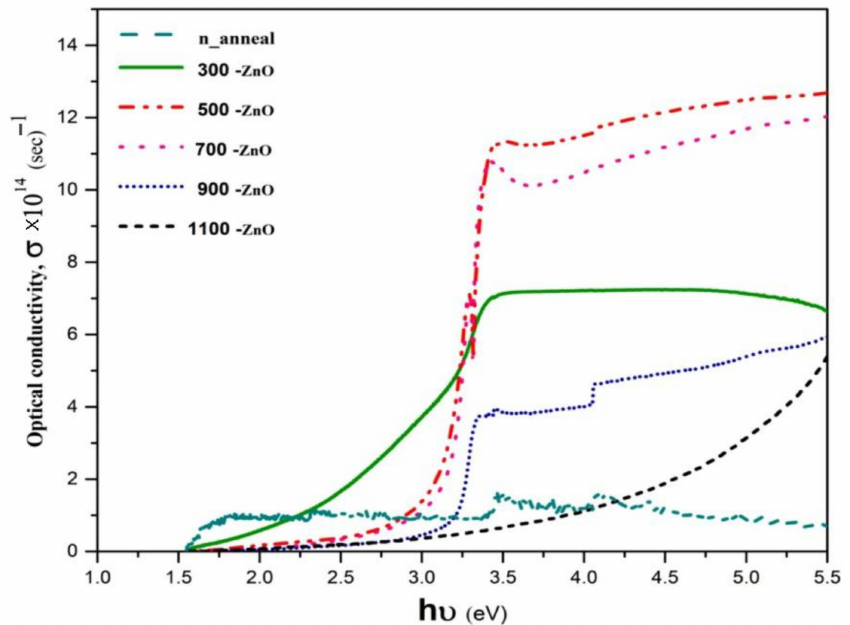
Figure 14. Optical conductivity of the prepared nanoparticles in terms of energy of landing pho- ton [88].